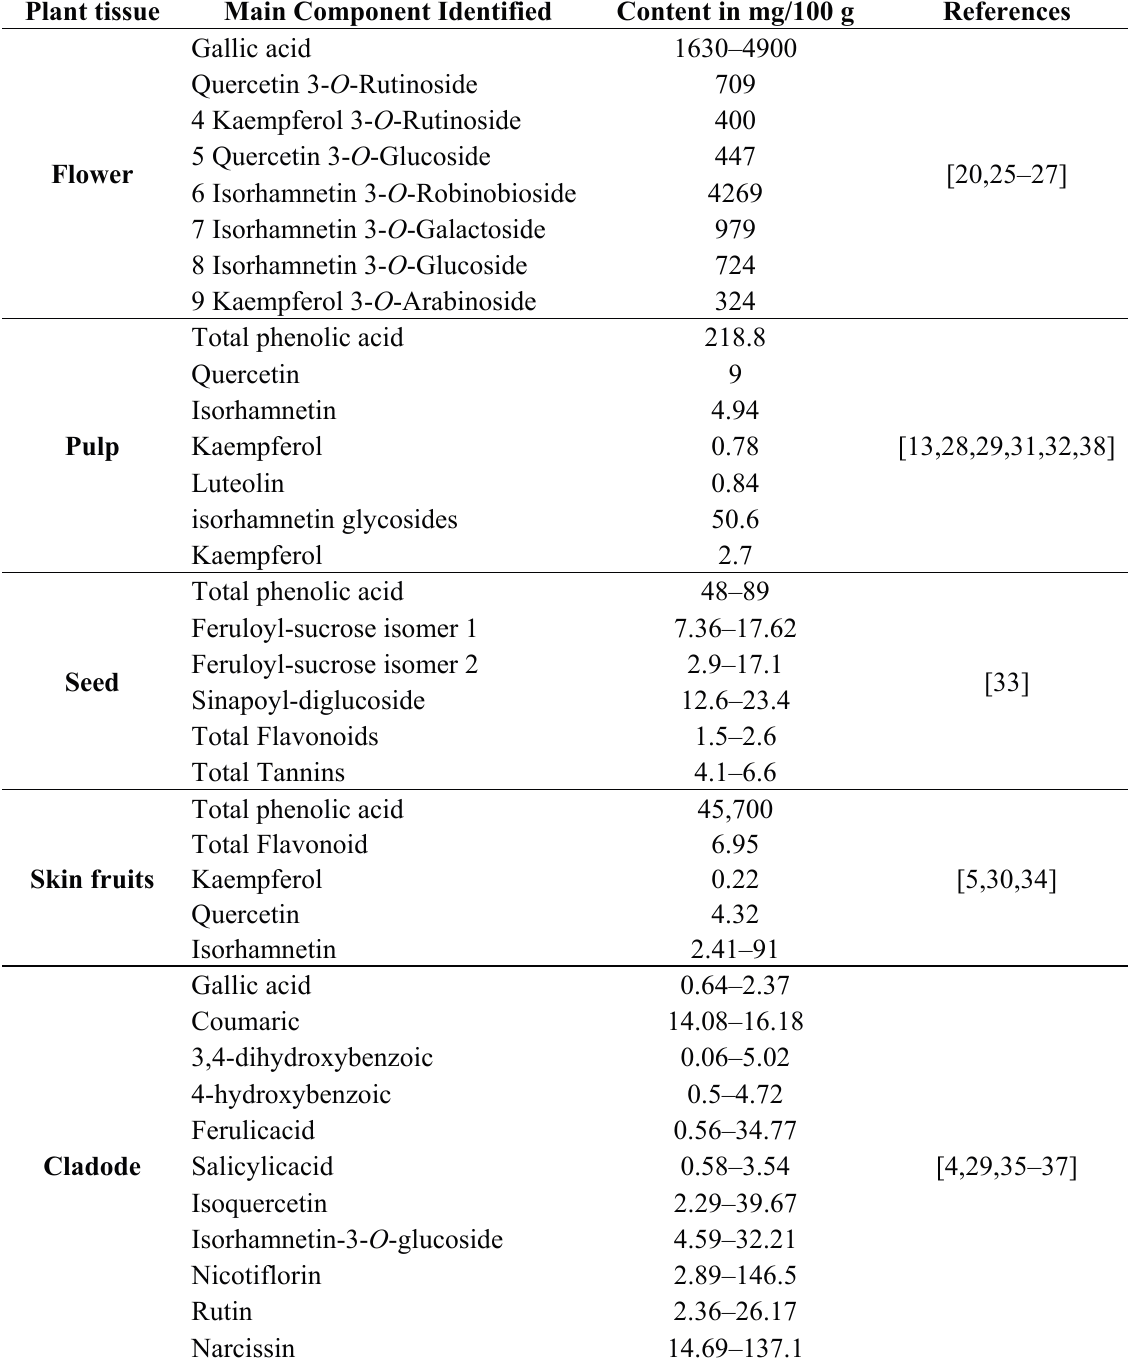
Table 1. Distribution and contents of phenols and flavonoids in the various parts of O. ficus-indica